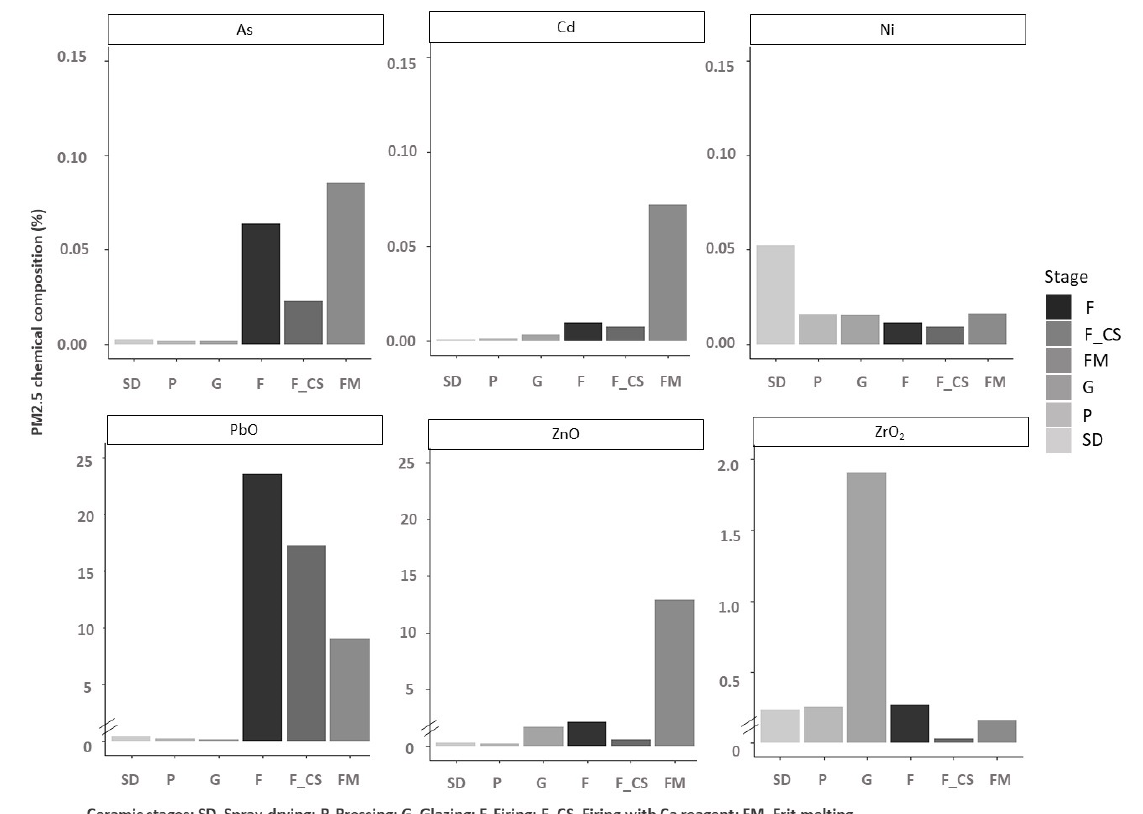
Figure 7. PM 2.5 composition in the different stages of ceramic process.